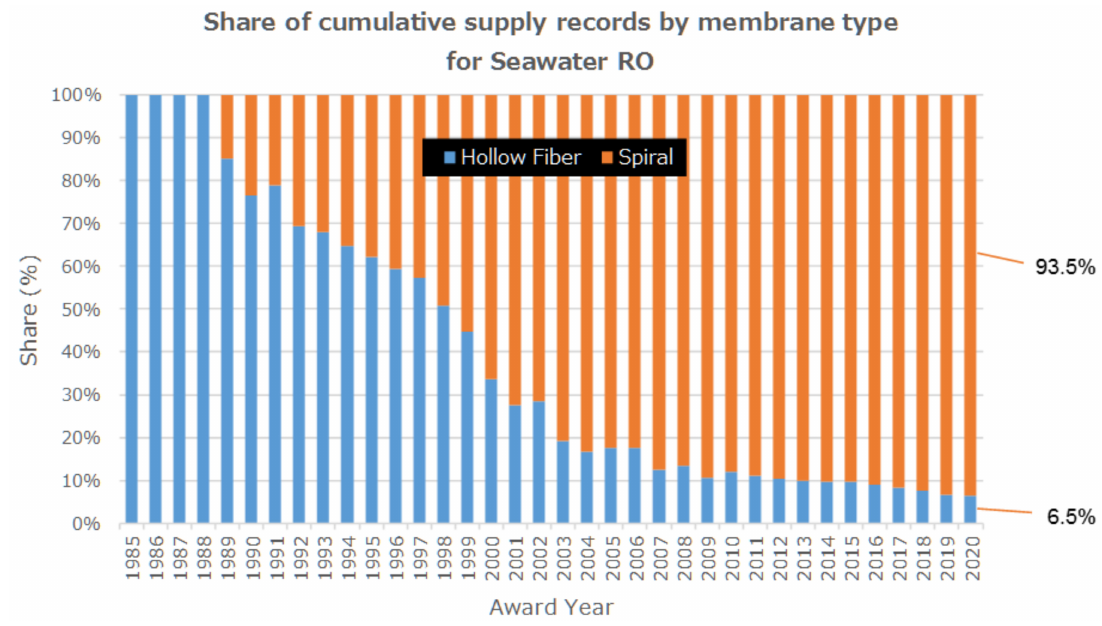
Figure 5. Share of cumulative supply record by membrane configuration type